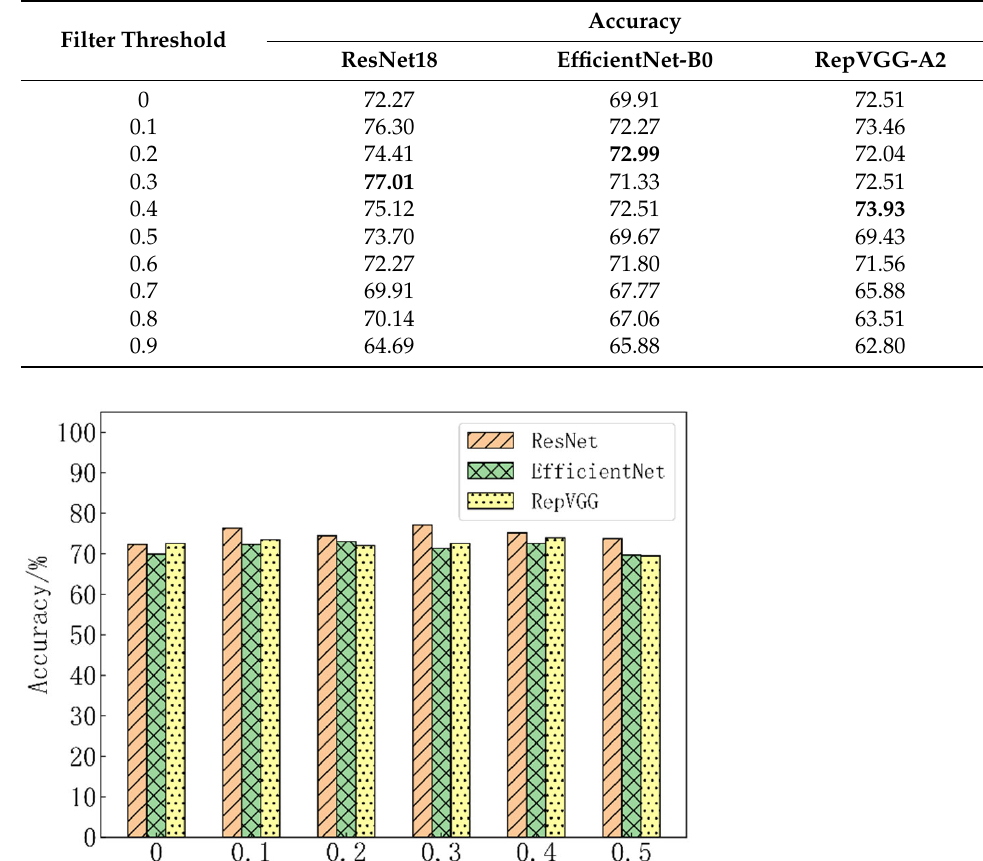
Table 4. Model accuracy values for spherular pearlite gradation with each filter threshold (%).